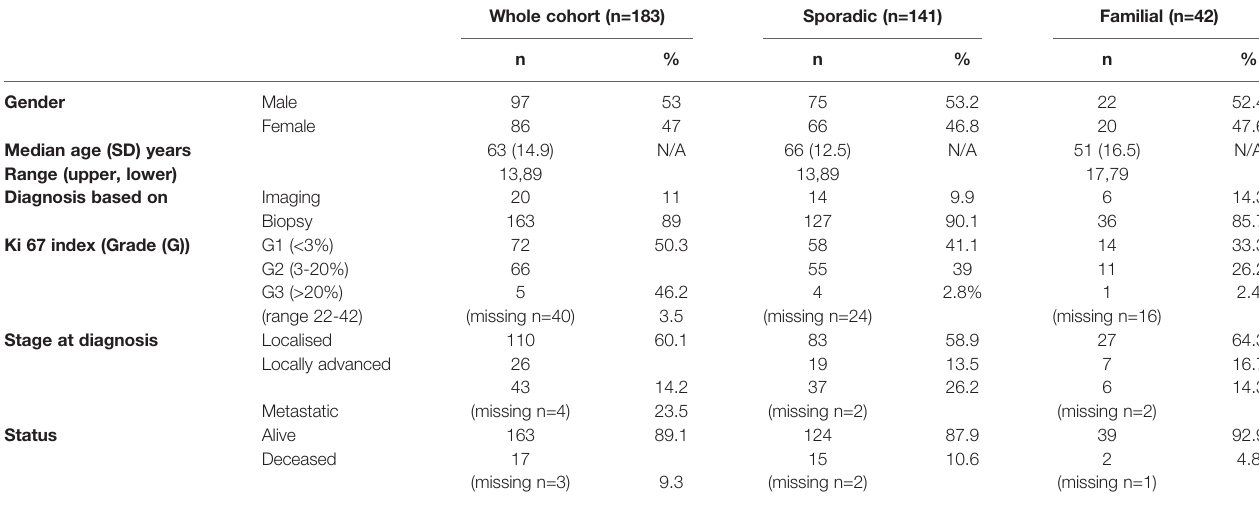
TABLE 1 | Summary of patients ’